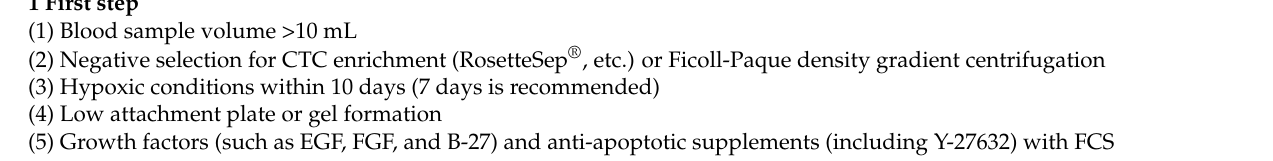
Table 5. Protocol currently recommended for CTC cell